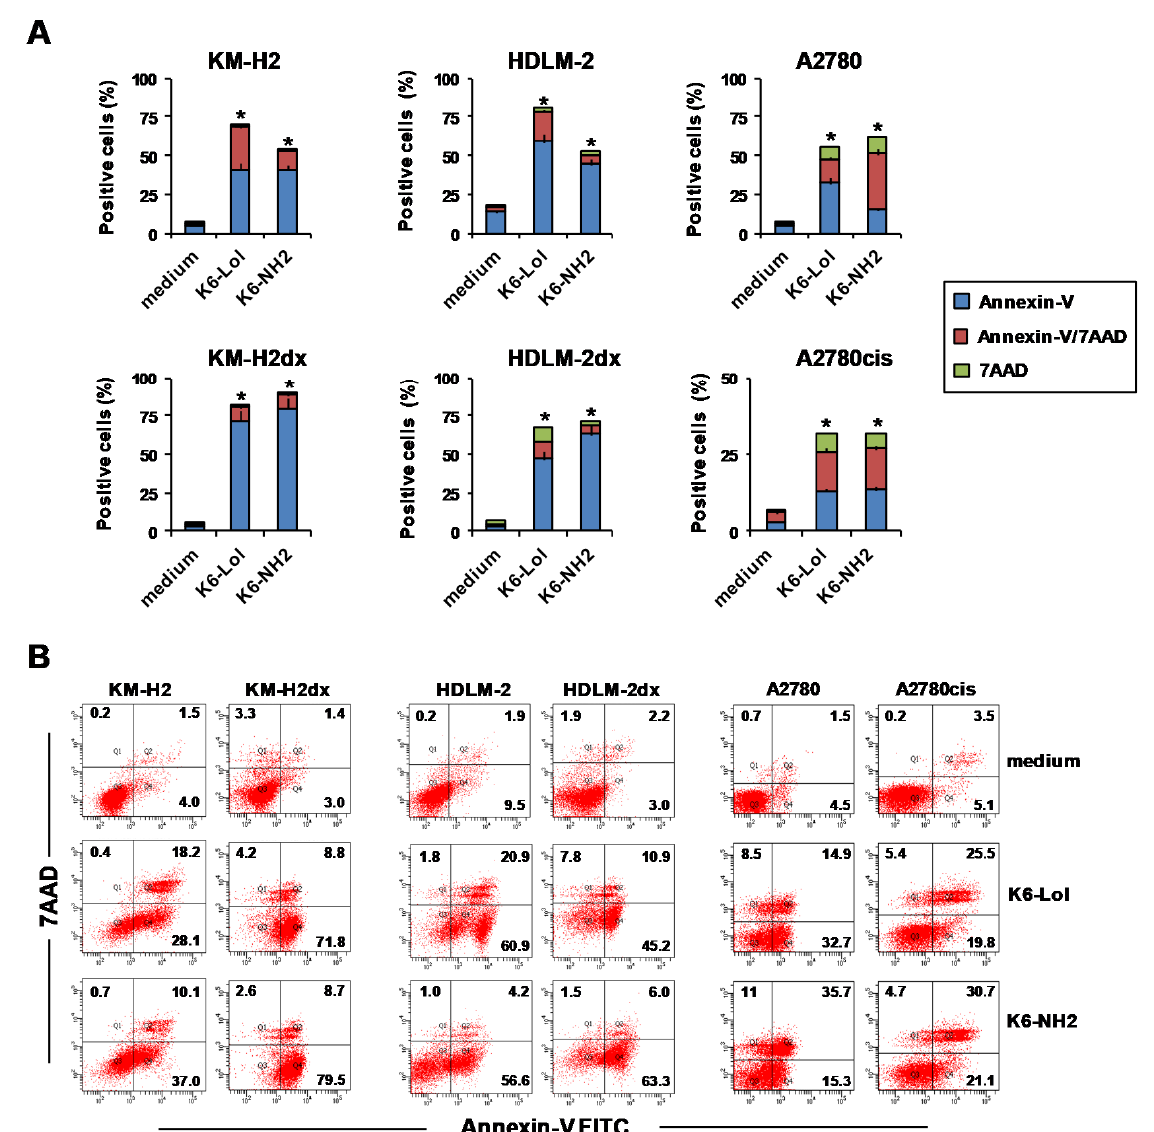
Figure 7. Annexin-V staining after peptaibol treatment. HRS cells (KM-H2, KM-H2dx, HDLM-2, and HDLM-2dx) and OvCa cells (A2780 and A2780cis) were treated with K6-Lol and K6-NH2 for 24 h. Then cells were double stained with Annexin-V-FITC and 7AAD and analyzed by flow cytometry. ( A ) Bar charts are the mean of three independent experiments showing the percentage of annexin-V and 7AAD positive cells. * p < 0.05 vs. medium. ( B ) Representative cytofluorimetric dot plots of Annexin-V-FITC and 7AAD staining.